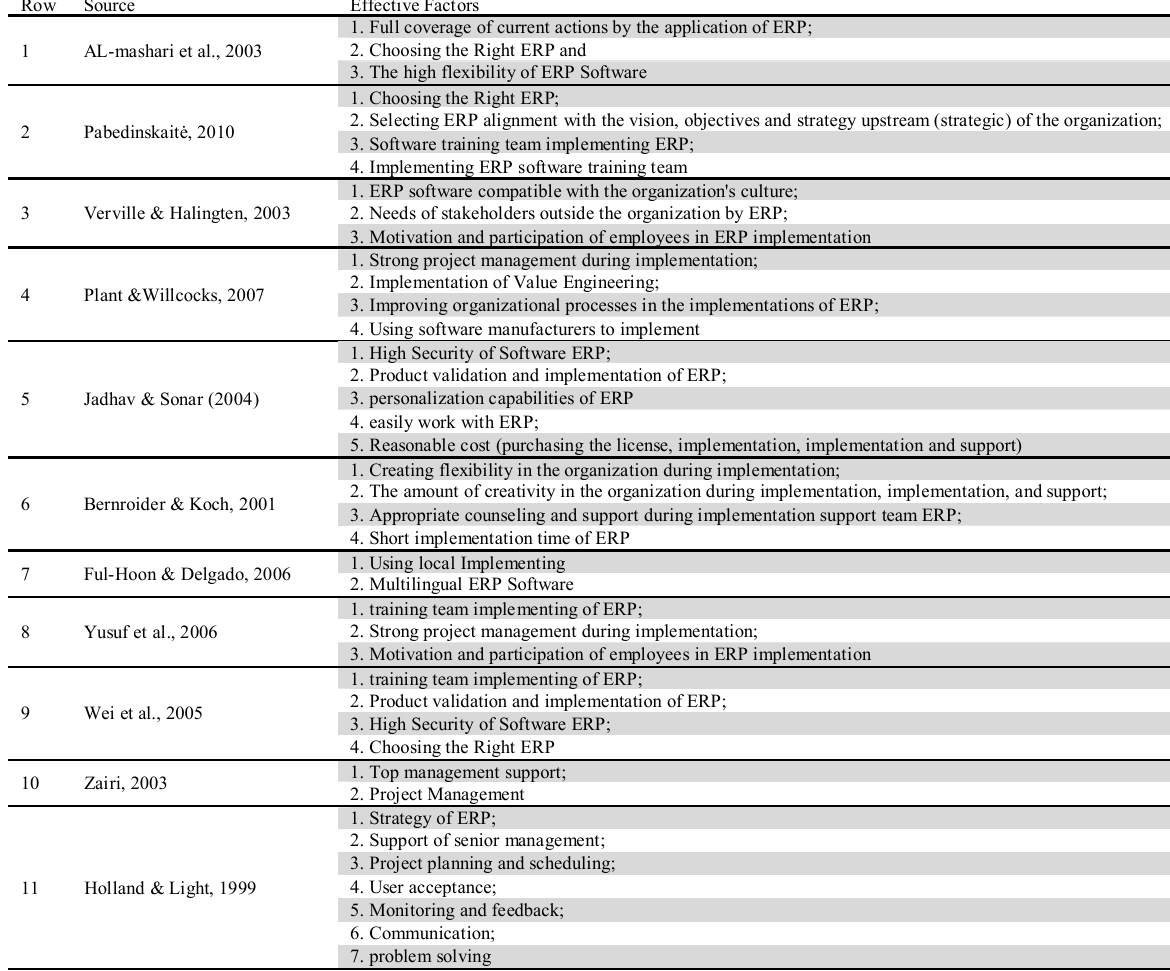
Factors influencing the successful deployment of ERP